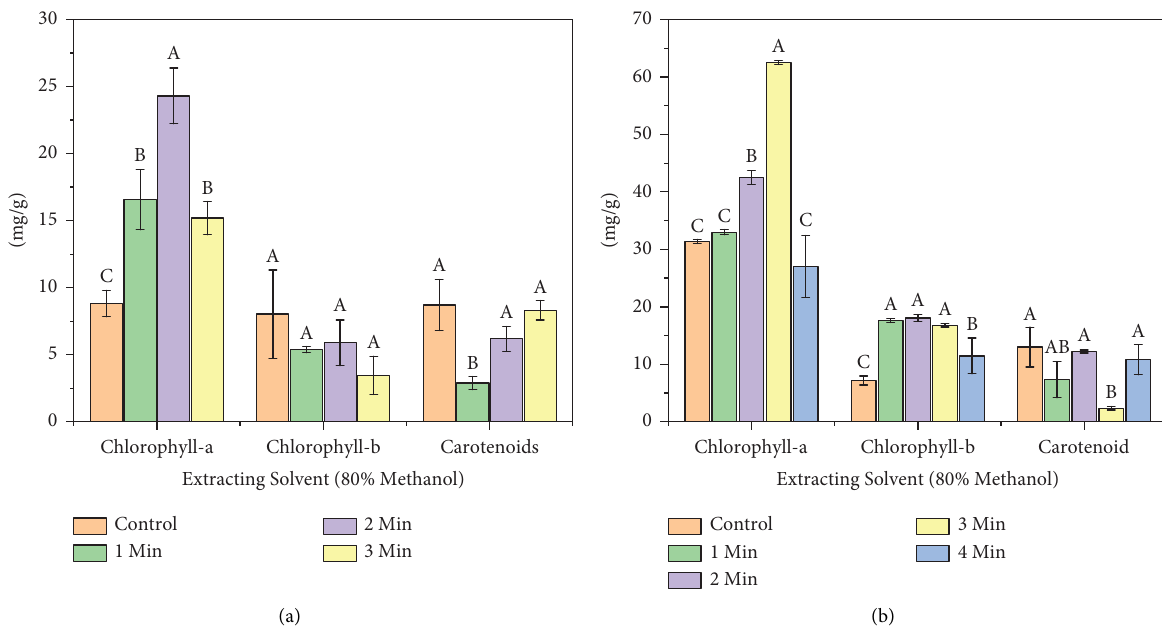
Figure 24: Estimation of chlorophyll and carotenoids contents in the leaves of seedlings germinated from control and plasma treated seeds of (a) radish and (b)